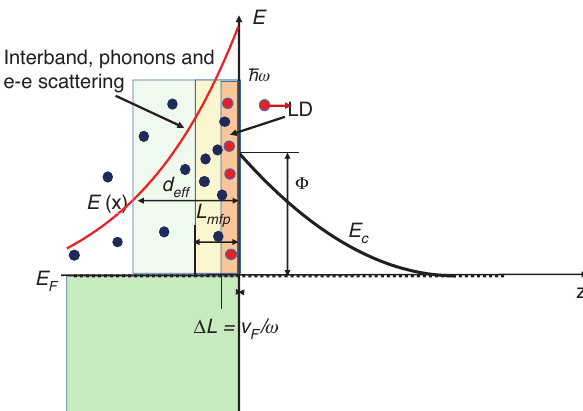
Figure 6: Energies and locations of non-equilibrium carriers generated via different SPP decay mechanisms. The carriers generated via interband, phonon/defect-assisted, and EE scattering-assisted transitions within the skin depth (or for a small nanoparticle within the entire bulk), as shown by black circles. With Landau damping, the carriers (red circles) are generated with a layer near the surface Δ L = v / ω , which is much thinner than the F skin